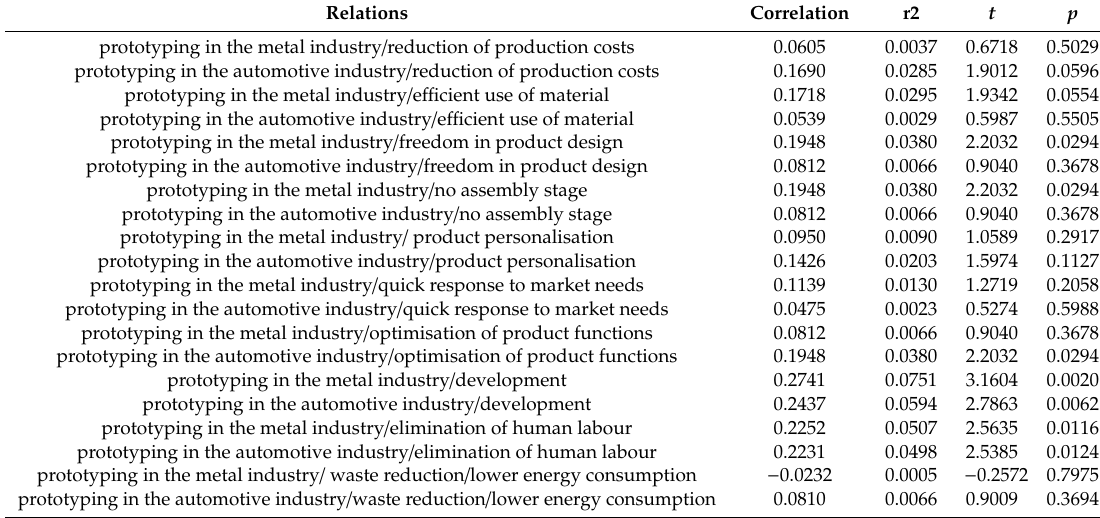
Table 4. Correlation analysis: prototyping process.